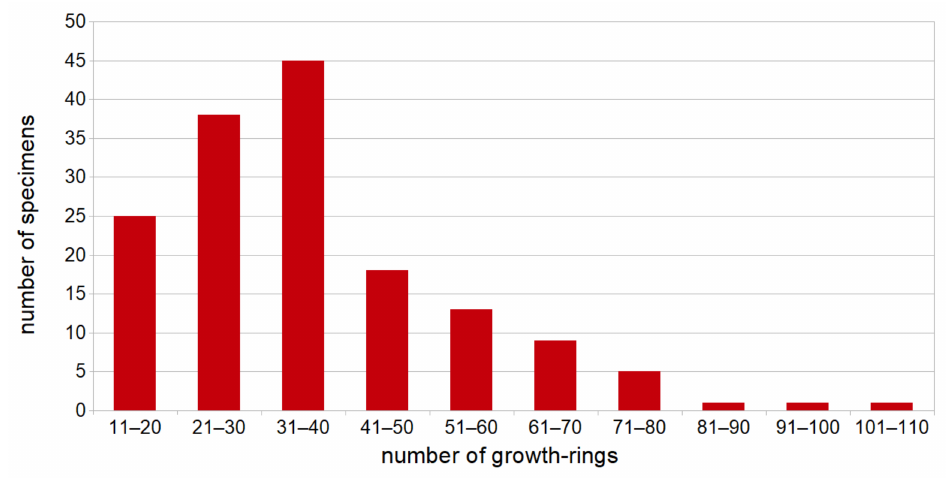
Figure 5. Distribution of tree age classes within analysed